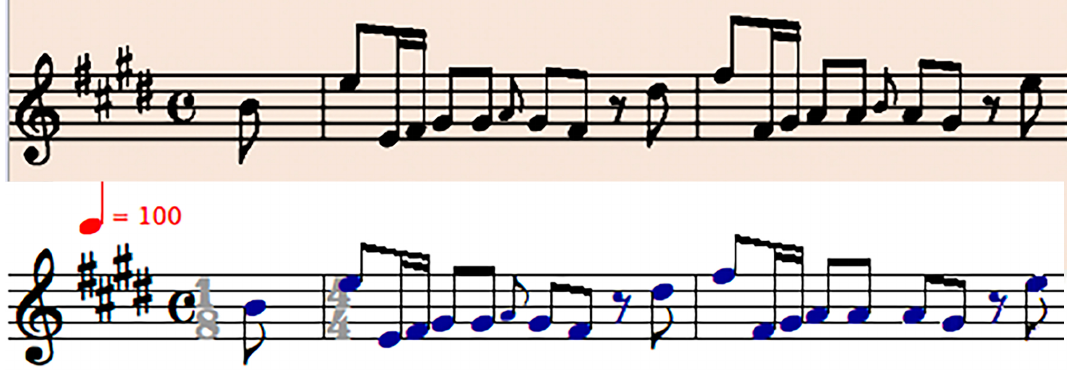
Figure 8. Incipit RISM ID no. 000100369. Sonatas . Christlieb Siegmund Binder. Both systems fail at recognizing the content within the image. ( a ) Photoscore output: The last appoggiatura is not detected; ( b ) Output of our system: It generates an ending barline not present in the original